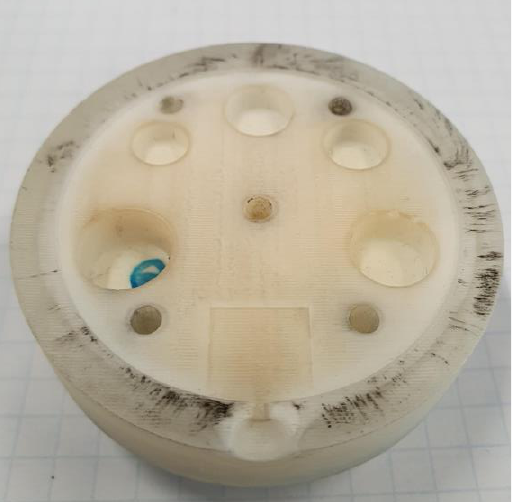
Figure 21. 3DIM cavity showing no signs of deterioration after 10 moulding shots.